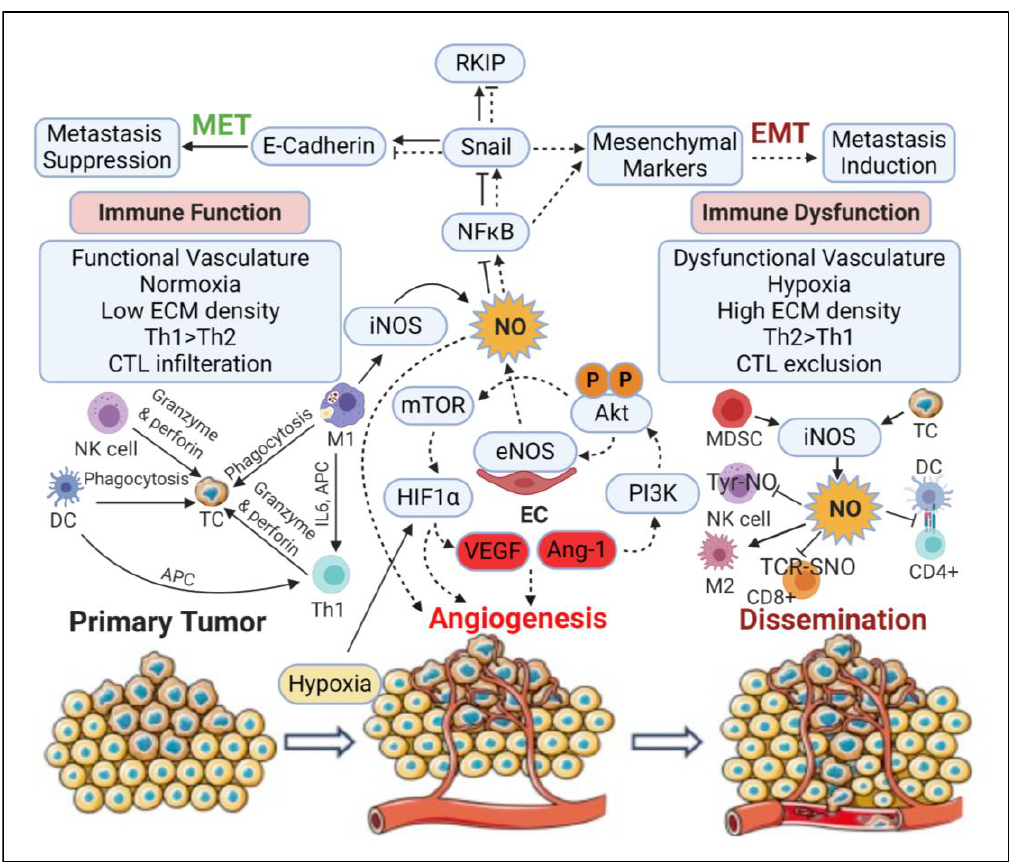
Figure 5. Low to moderate levels of NO induce SNAIL and lead to epithelial to mesenchymal transition, increased angiogenesis and immune dysfunction promoting tumour progression and dissemination. High levels of NO (e.g., from M1 macrophages or Th1 lymphocytes) lead to tumour toxicity, repress EMT and mount an anti-tumour immune response. (low NO, dashed line; high NO, solid line) Created with BioRender.com.